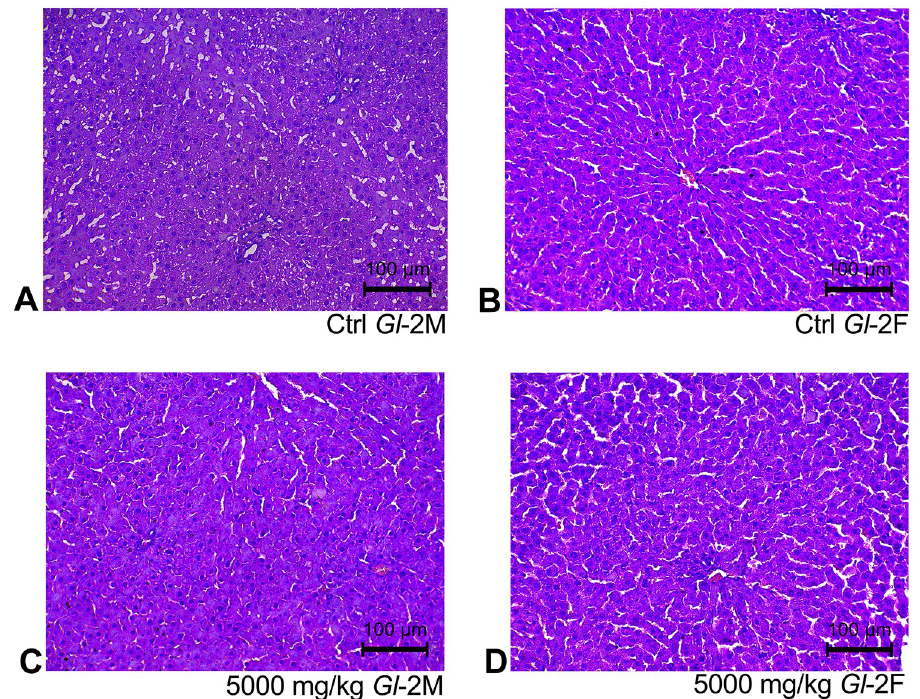
Control (Ctrl) groups. C–D: Treated groups consuming the 5000 mg/kg bw/day